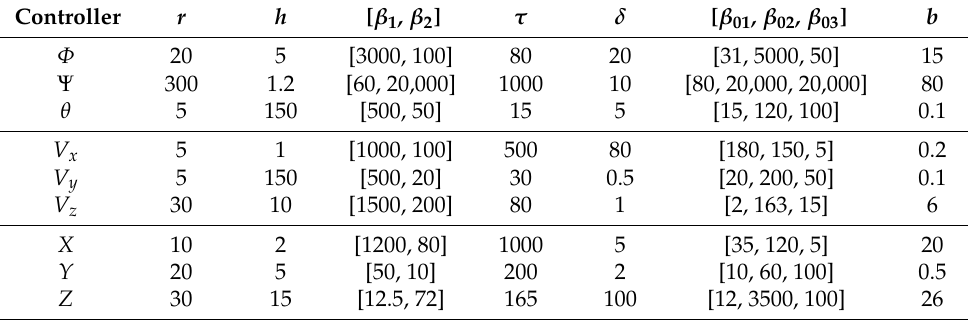
Table 6. Parameters of